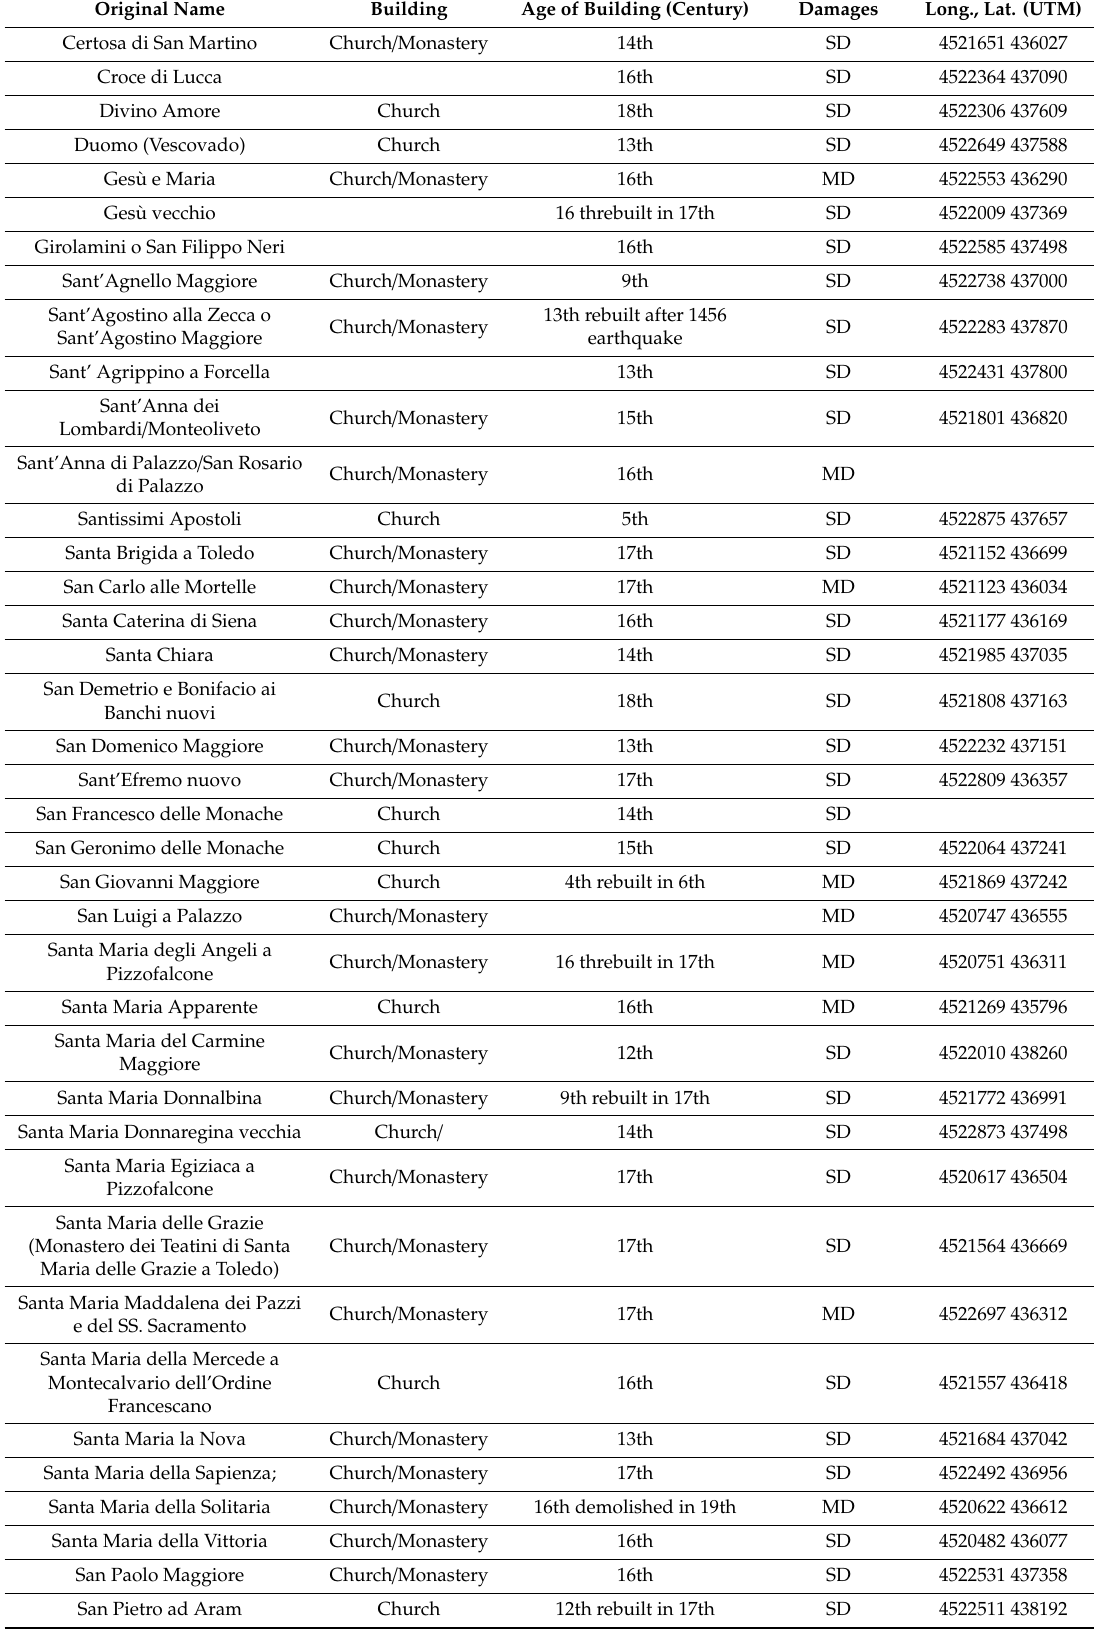
Table A5. The historical buildings of Naples damaged by the 1805 earthquake [1,5–7,44,45,49,50]. MD = Minor Damage; SD = Serious Damage; GD = Great